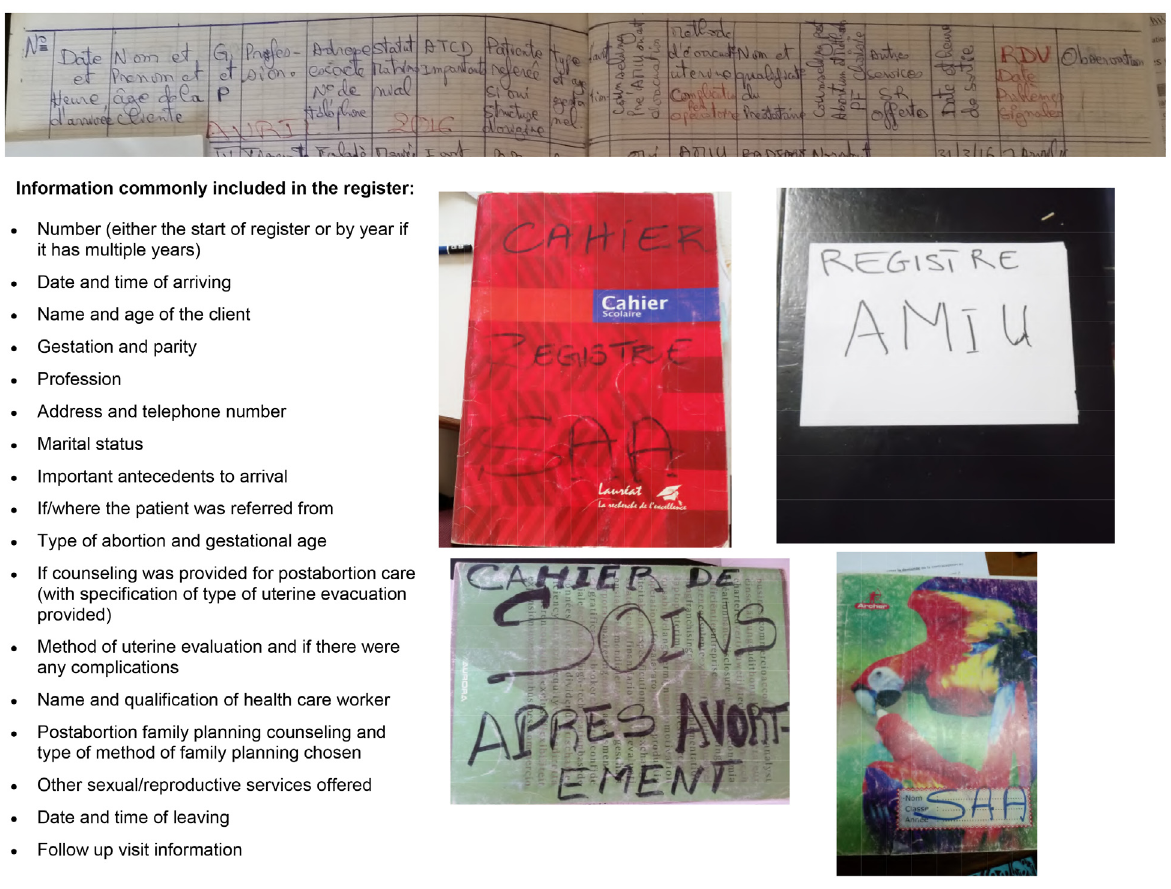
Figure 2. Examples of PAC Unofficial Registers with commonly included reported information. Common information collected by the Togolese Ministry of Health’s registers and images of the various registers utilized by family planning services reporting